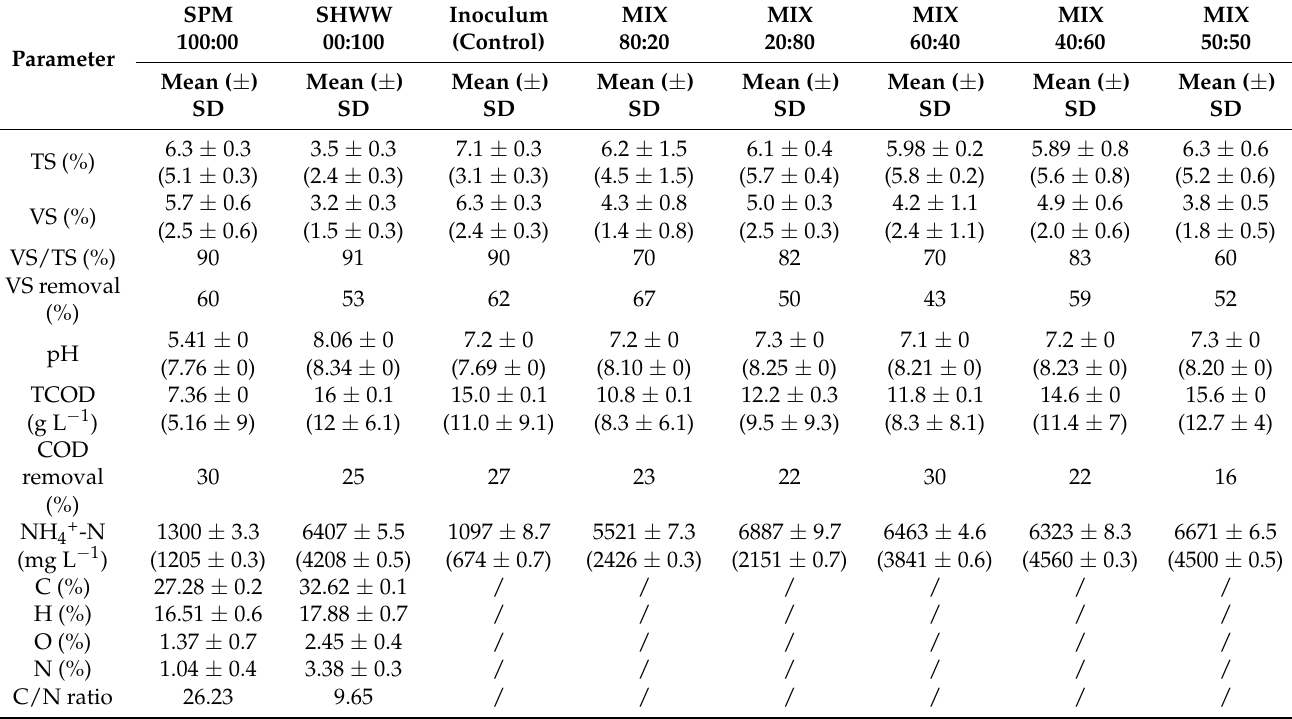
Table 4. Characteristics of SHWW, SPM and inoculum with respective standard deviation